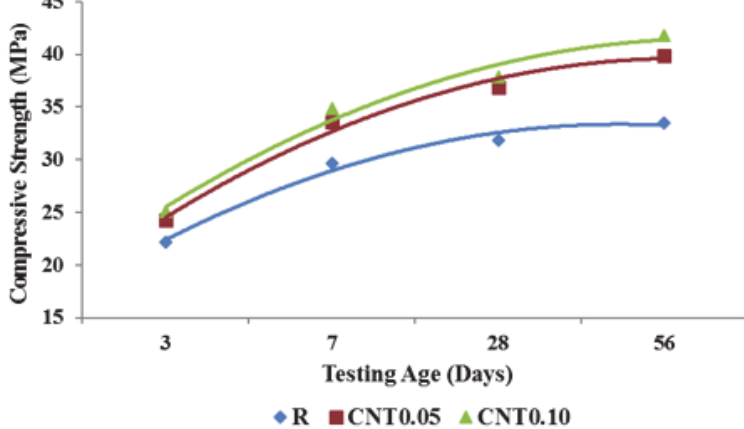
Figure 4: Compressive strength of concrete mixes with and without